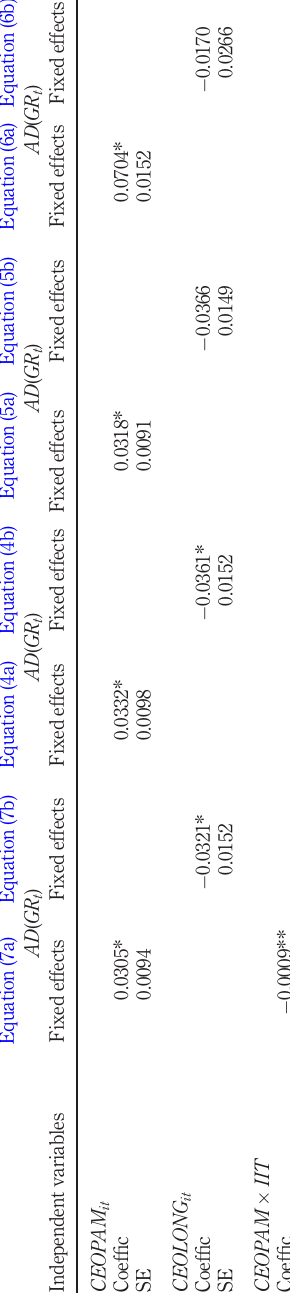
Table III. Effect of